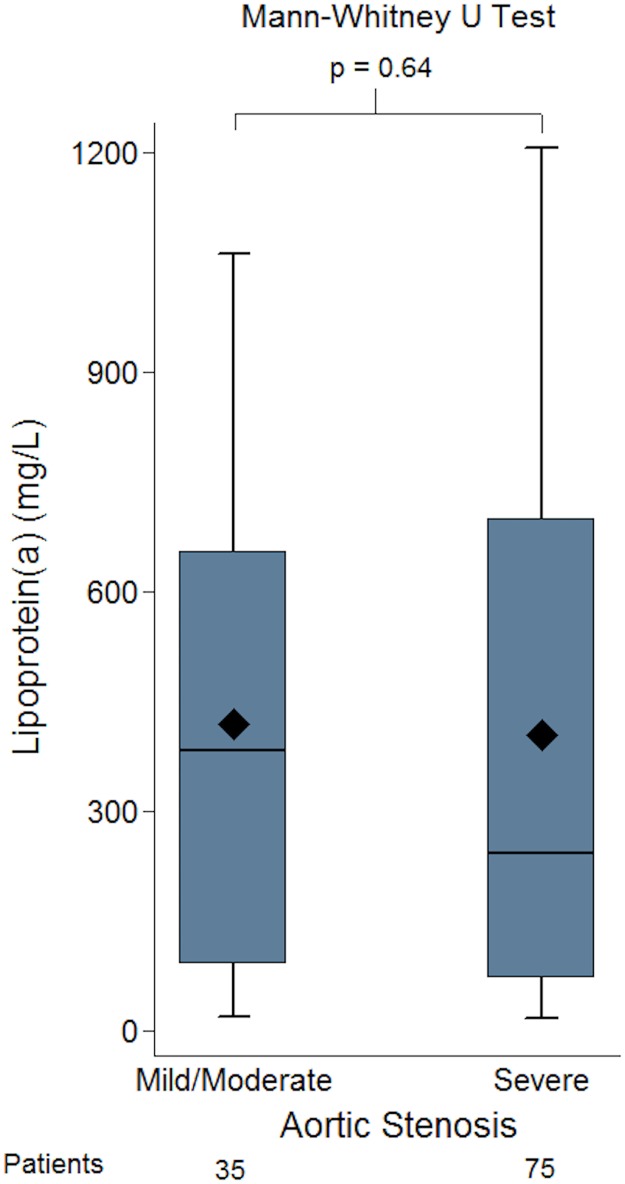
Box-plots of lipoprotein(a) (Lp[a]) concentration in groups of patients with mild/moderate and severe aortic stenosis (AS).There was no difference in the level of Lp(a) in the patients whether they had mild/moderate or severe AS.